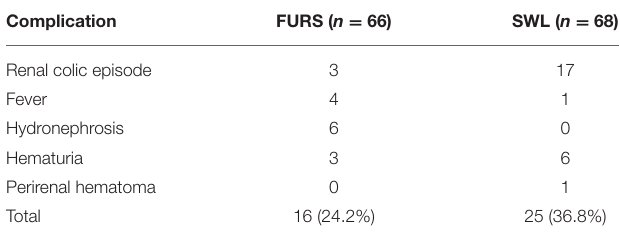
TABLE 2 | Complications of FURS and